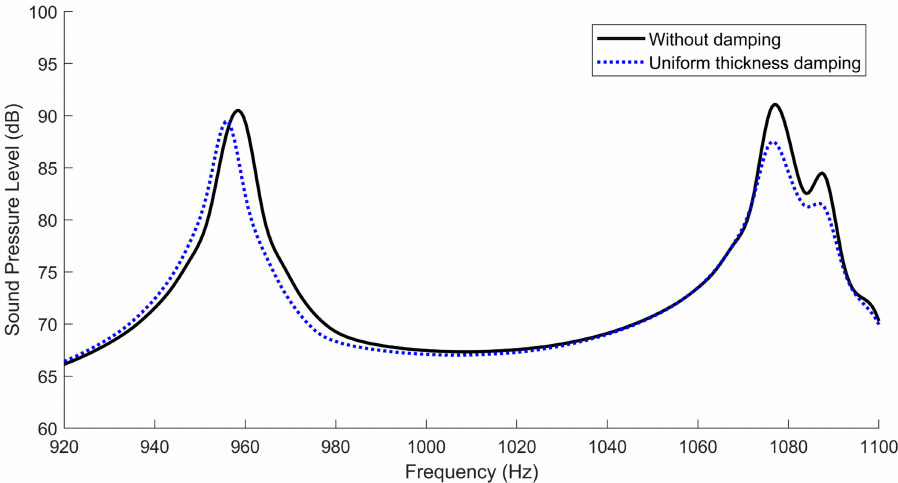
Figure 18. Sound pressure level of plates embedded with ABH array with/without damping